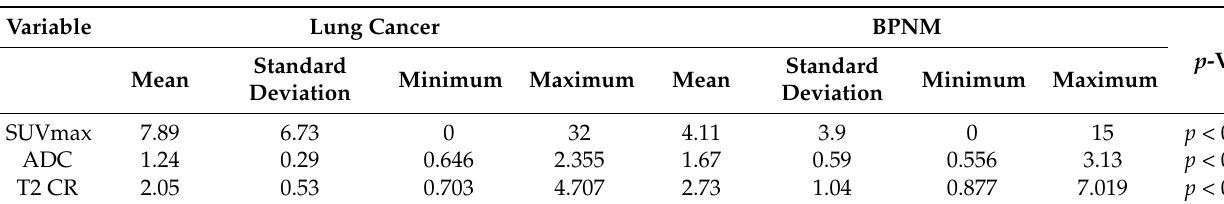
Figure 7. The receiver operating characteristic (ROC) curve presents the diagnostic performance of SUVmax for distinguishing the benign pulmonary nodule and mass (BPNM) from lung cancer. The area under the ROC curve 67.5%. SUV max = 3.605, sensitivity 65.25%, specificity 60.0%, accuracy 64.3%. Detail of SUVmax, ADC, and T2 CR between lung cancer and BPNM were shown in Table 4. In relationships between the mean SUVmax and lung cancer/BPNM, the mean SUVmax (7.89 ± 6.73) of lung cancer was significantly higher than that (4.11 ± 3.90) of BPNM ( p < 0.0001) (Figure 8, Table 4). Table 4. SUVmax, ADC, and T2 CR between lung cancer and BPNM.